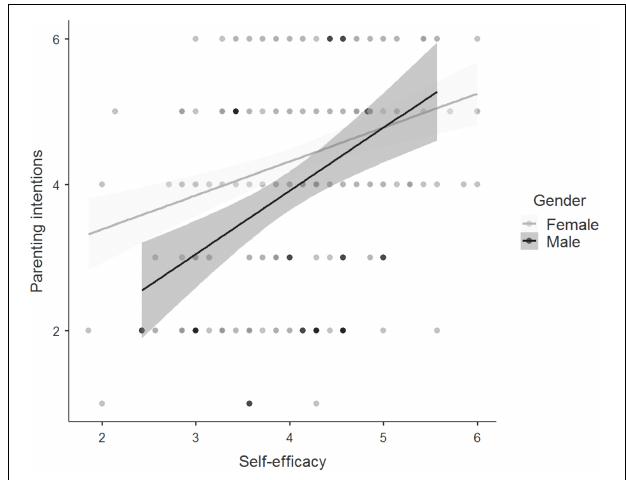
FIGURE 6 | Regression plot showing the relationship between self-efficacy regarding future parenthood and the strength of parenting intentions among men and women. Points represent individual responses, n = 262, and the gray shaded region represents the 95% confidence region. Responses were on 6-point Likert scales. Higher scores on self-efficacy indicated a higher level of self-efficacy regarding future parenthood. Higher scores on the strength of parenting intentions indicated a stronger intent to become a